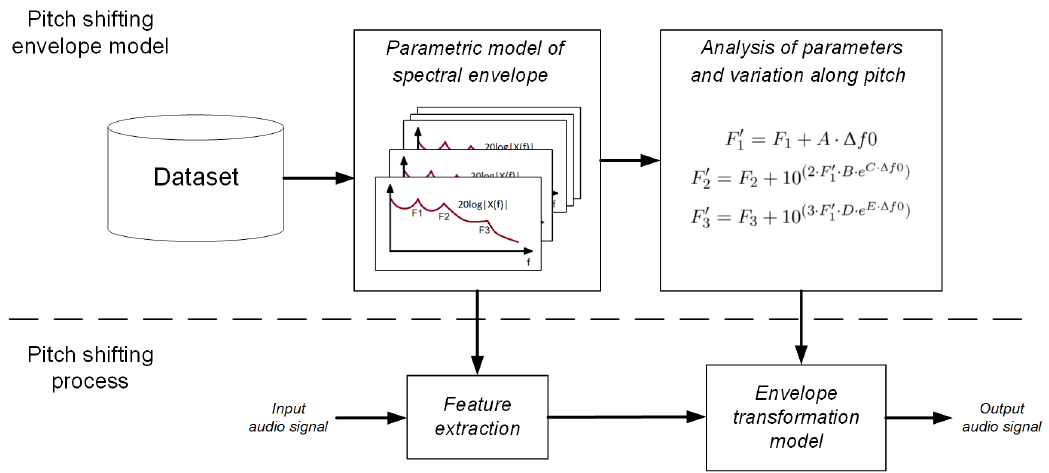
Figure 1. Diagram of the analysis of the envelope behavior and our pitch shifting scheme with spectral envelope